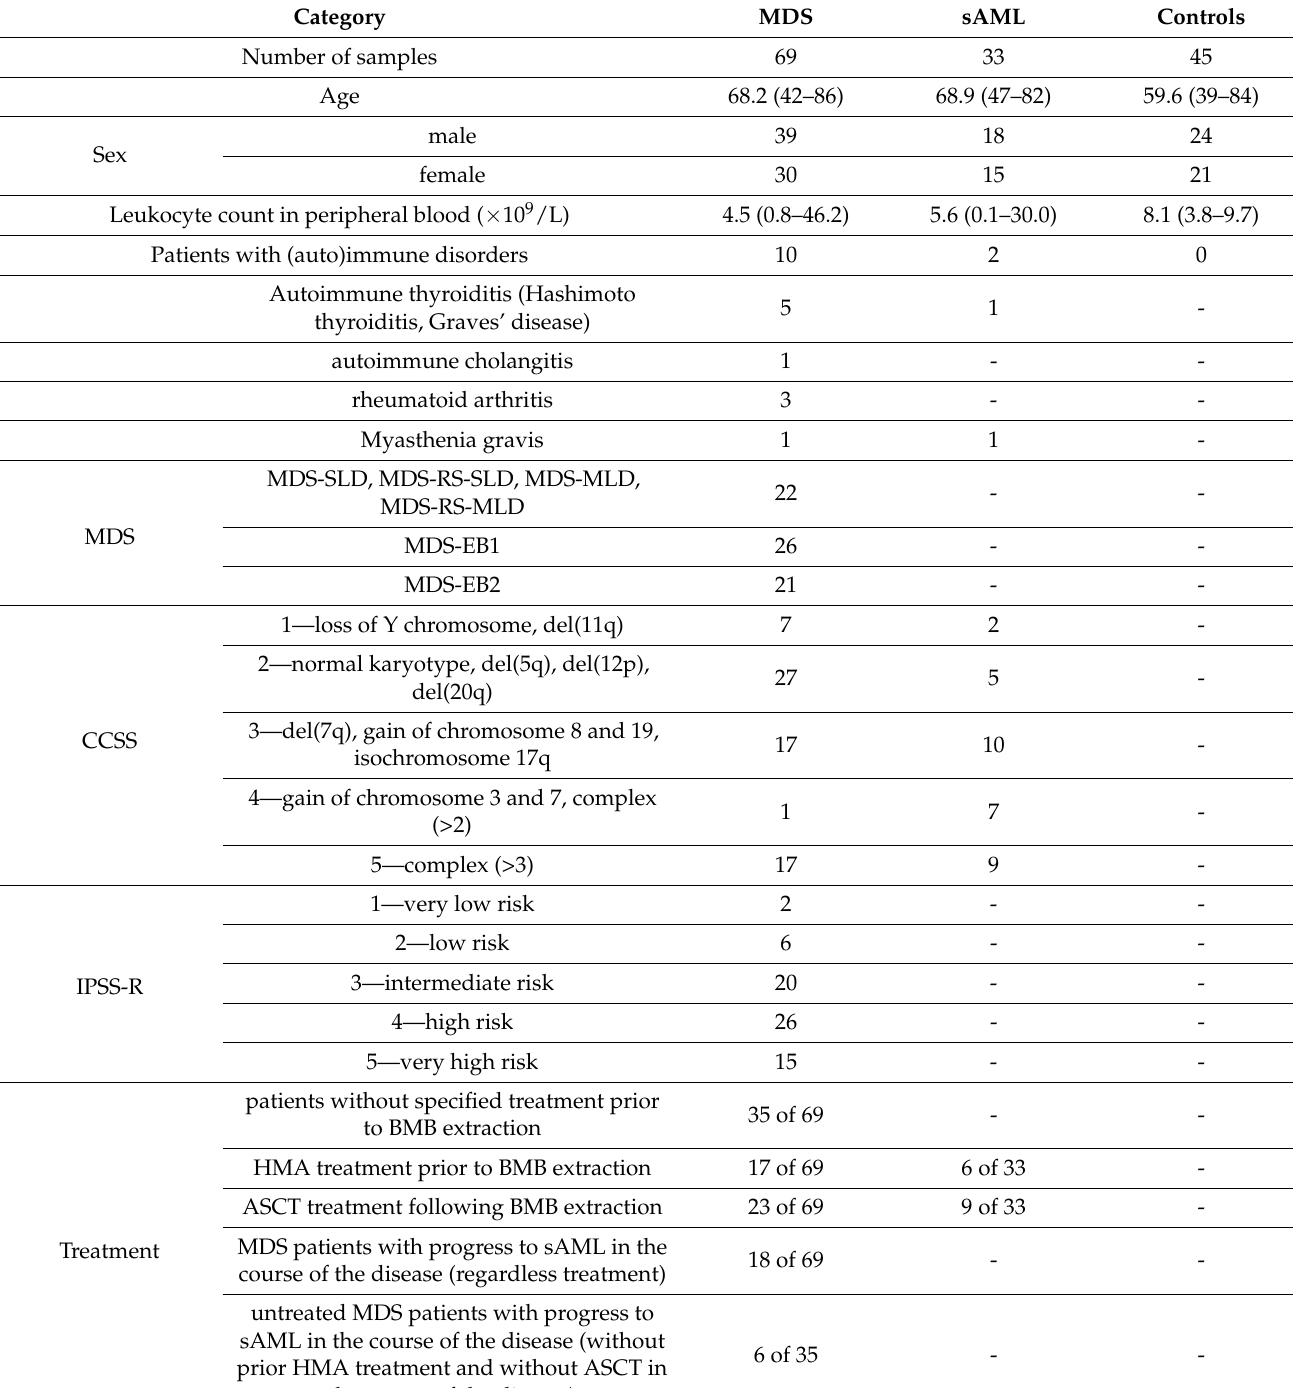
Table 1. Clinico-pathological characteristics and sample specifications in terms of risk factors, treatment, and